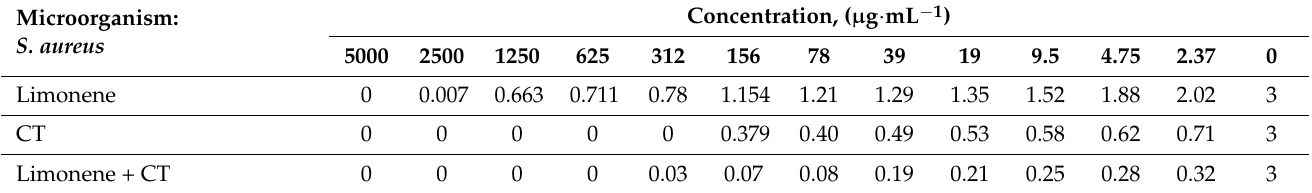
Table 4. Optical densities obtained after 24 h of exposure of S. aureus at different treatments.